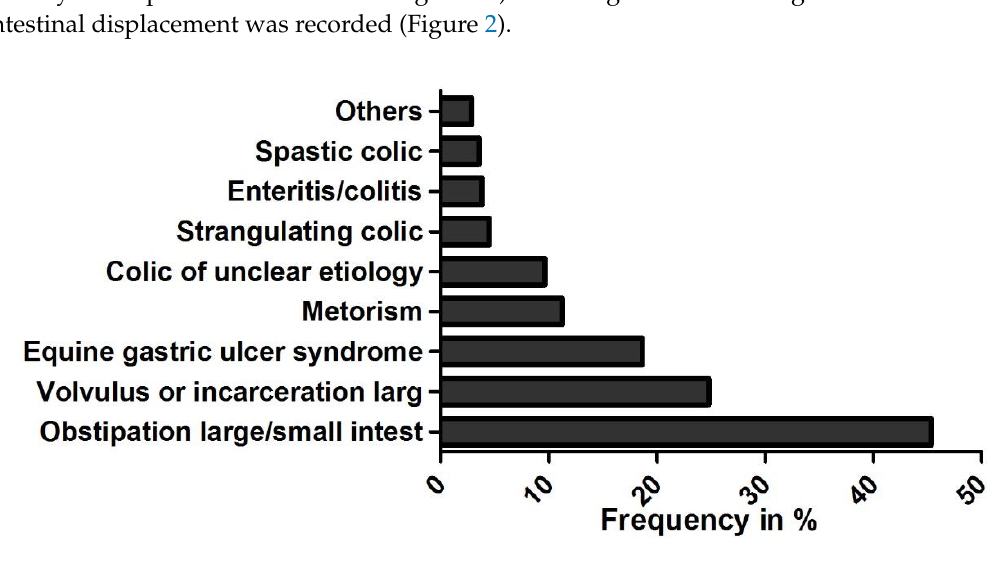
Figure 2. Colic diagnoses following admission % ( n = 311).